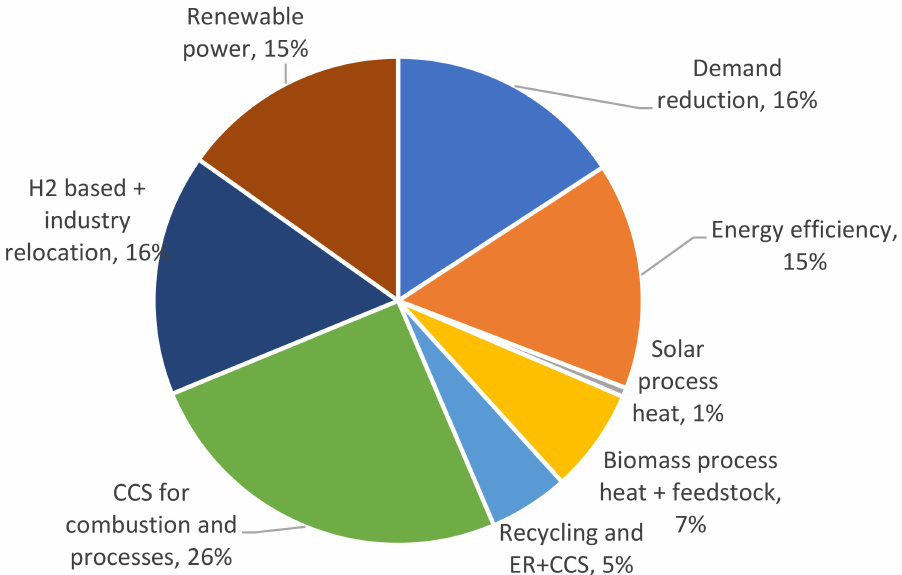
Figure 7. Breakdown of the estimated CO 2 emissions reductions in the 1.5 ◦ C case compared to the PES, 2050. Note: the breakdown has been estimated by removing the technology penetration of each measure from the 1.5 ◦ C case to arrive back at the estimated PES results in 2050 based on the following order: demand reduction, energy efficiency, renewable process heat, plastic waste treatment, renewable feedstocks, CCUS and renewable power/process heat electrification. The breakdown and the average mitigation costs may change somewhat if a different order is